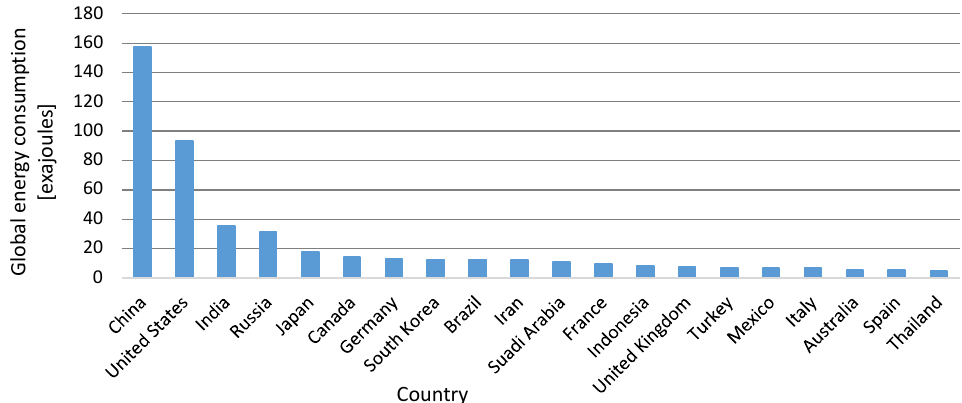
Figure 3. Global primary energy consumption in 2021 by country [26].